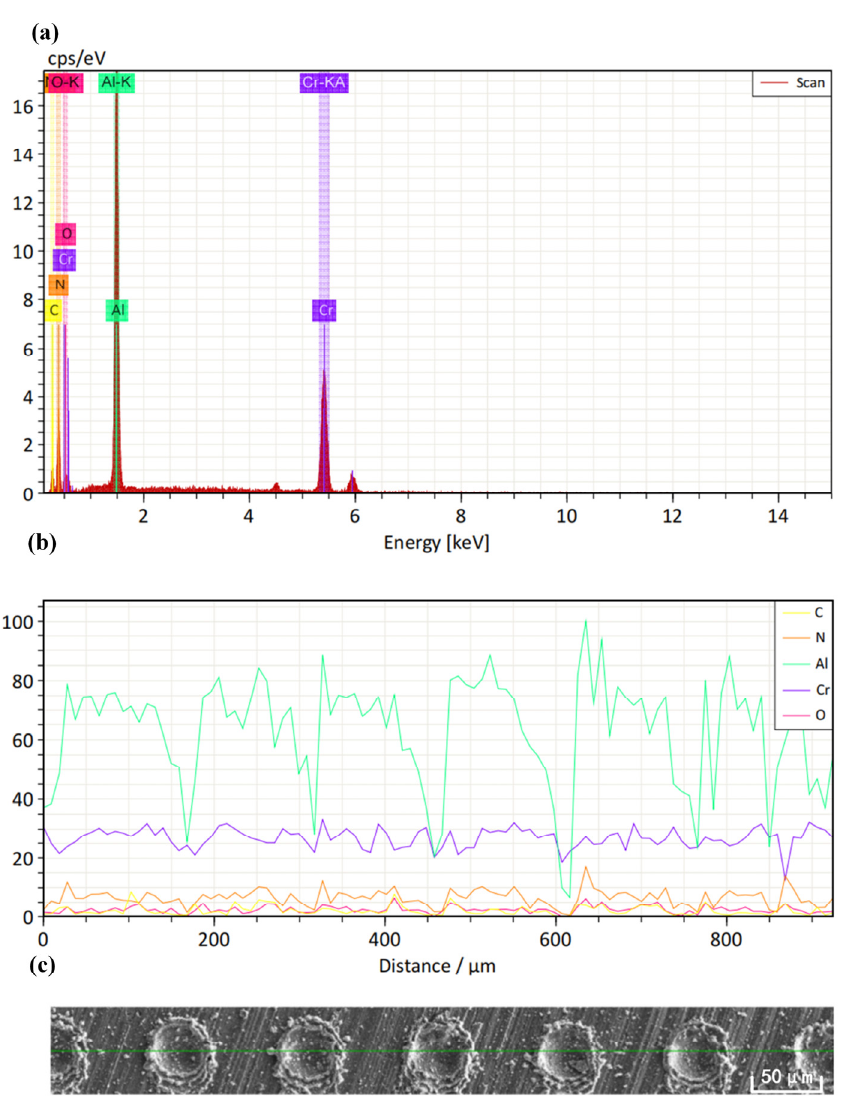
Figure 4. EDS line-scanning elemental analysis of the AlSiTiN–AlCrN coating. ( a ) XRD energy spectrum. ( b ) Line scan element content diagram. ( c ) Line scan local map.